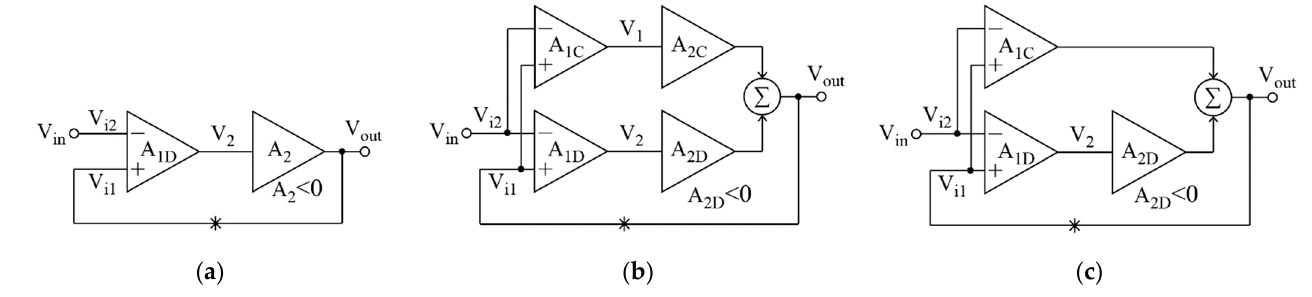
Figure 2. Block diagrams of circuits: ( a ) in Figure 1a; ( b ) in Figure 1b; ( c ) in Figure 1c.